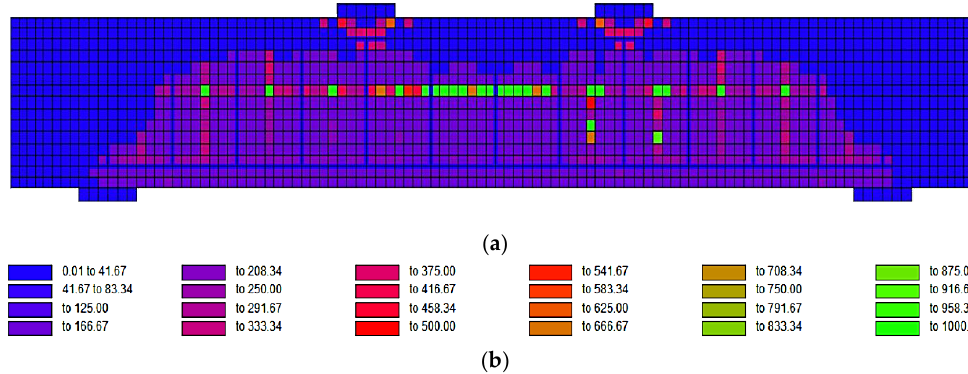
Figure 21. Crack Information of Specimen (CBA): ( a ) Crack Width and ( b ) Crack Spacing.